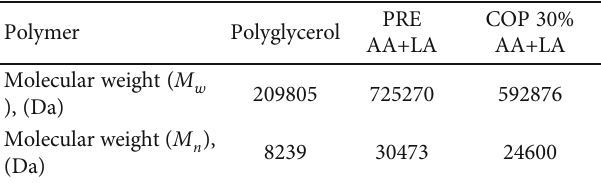
Table 2: The molecular weight of synthesized polymers. Polymer